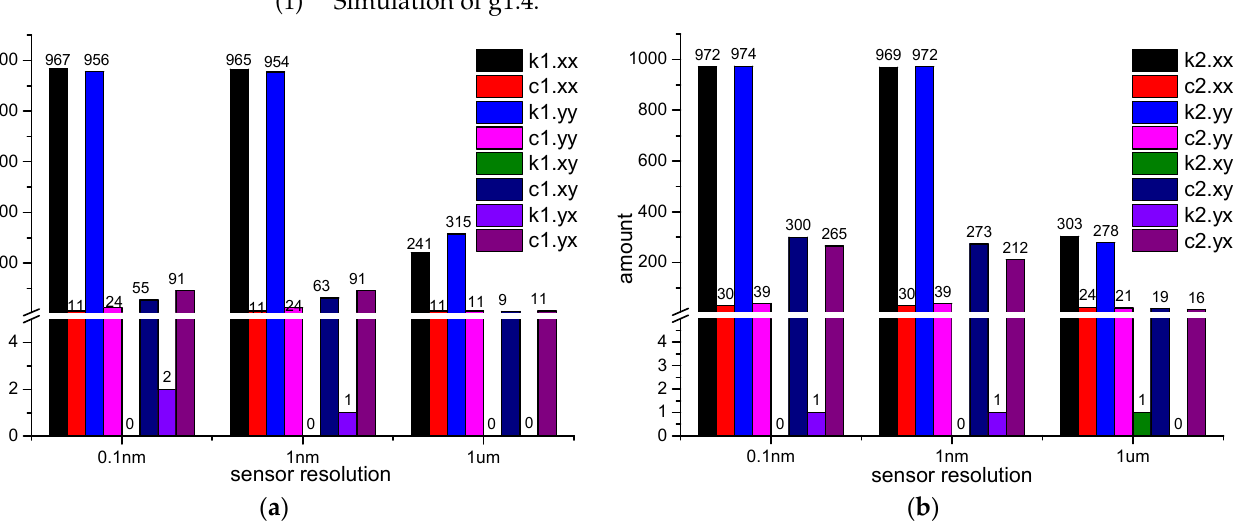
Figure A9. Statistical results of the amount of the frequencies, at which the related error is less than 10% and the absolute value is less than 10: ( a ) #1 bearing; ( b ) #2 bearing. (2) Simulation of g1.1.